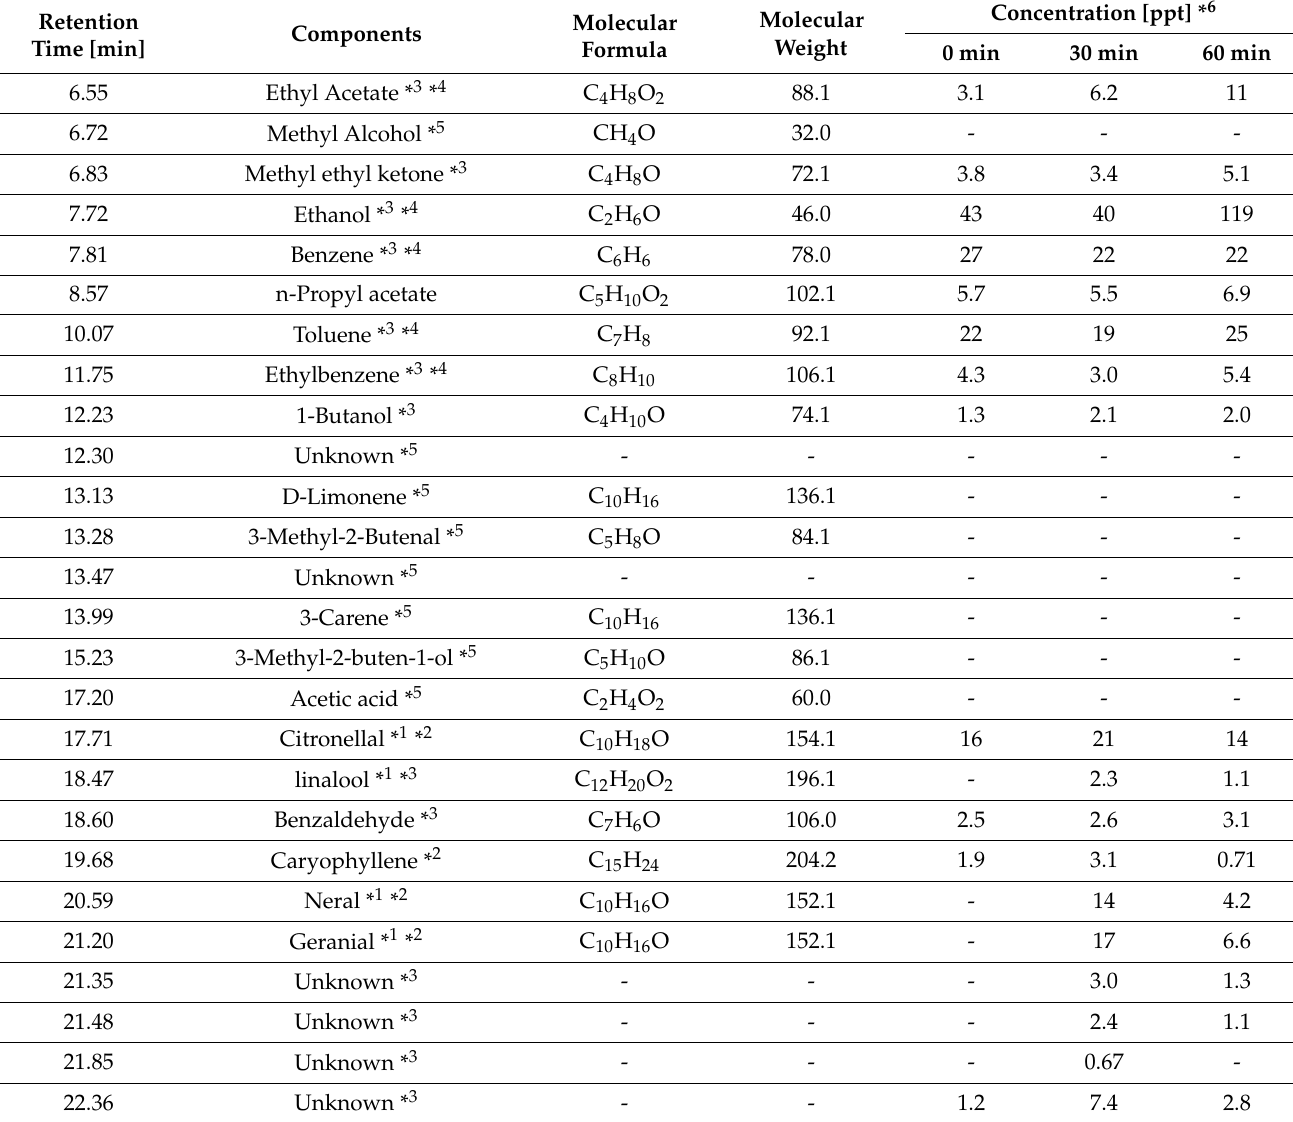
Table 6. The concentration of each component from room air including diffused melissa